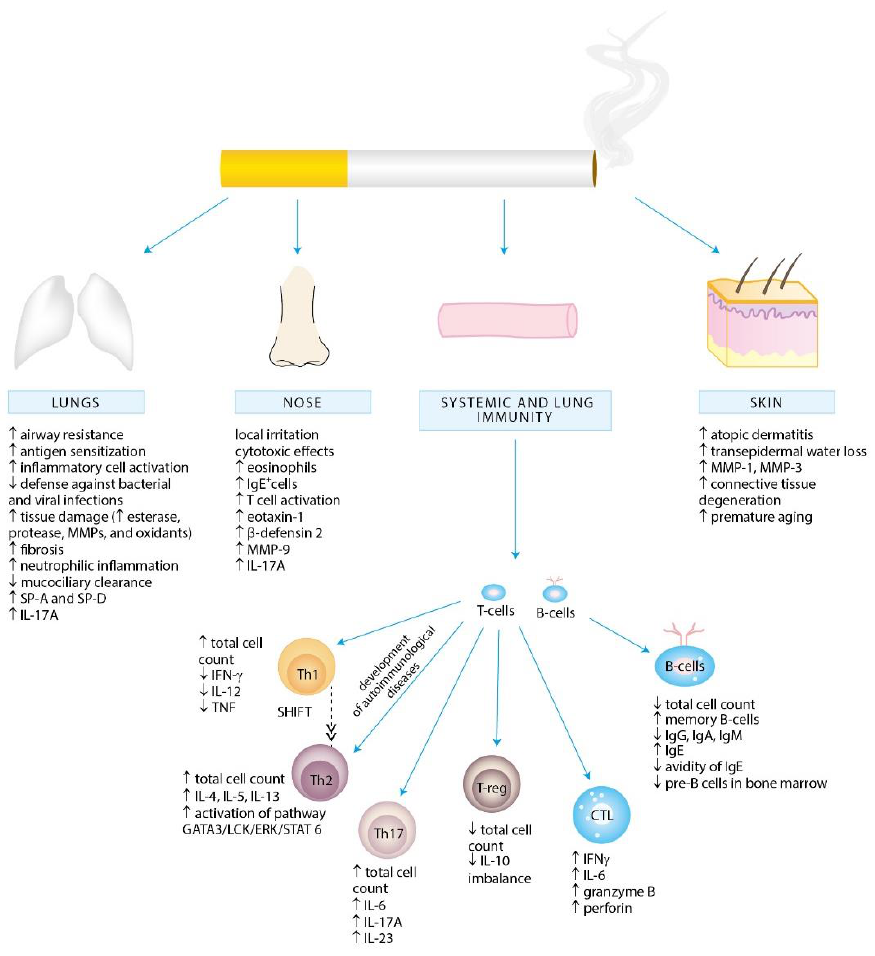
Figure 1. Cigarette smoke exposure-associated alternations in local and systemic immunity promoting inflammation and allergy development.